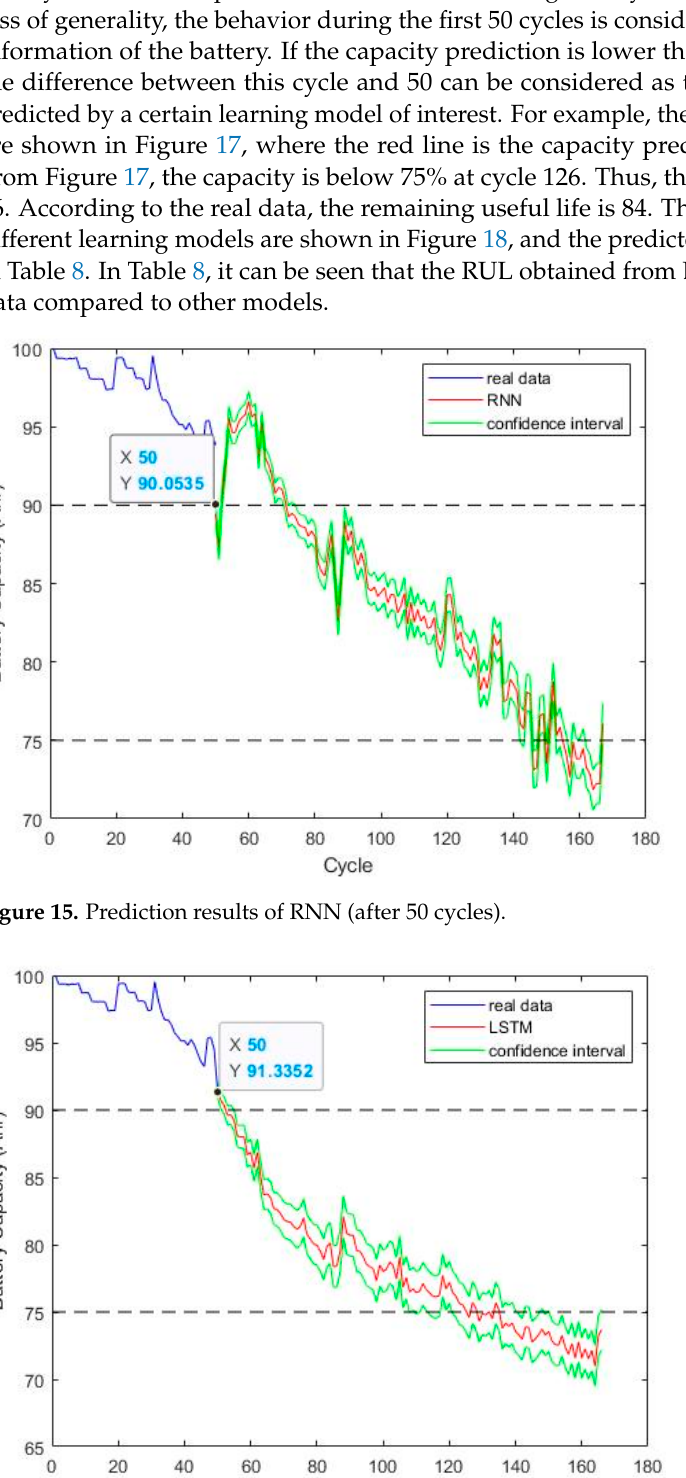
Figure 16. Prediction results of LSTM (after 50 cycles).